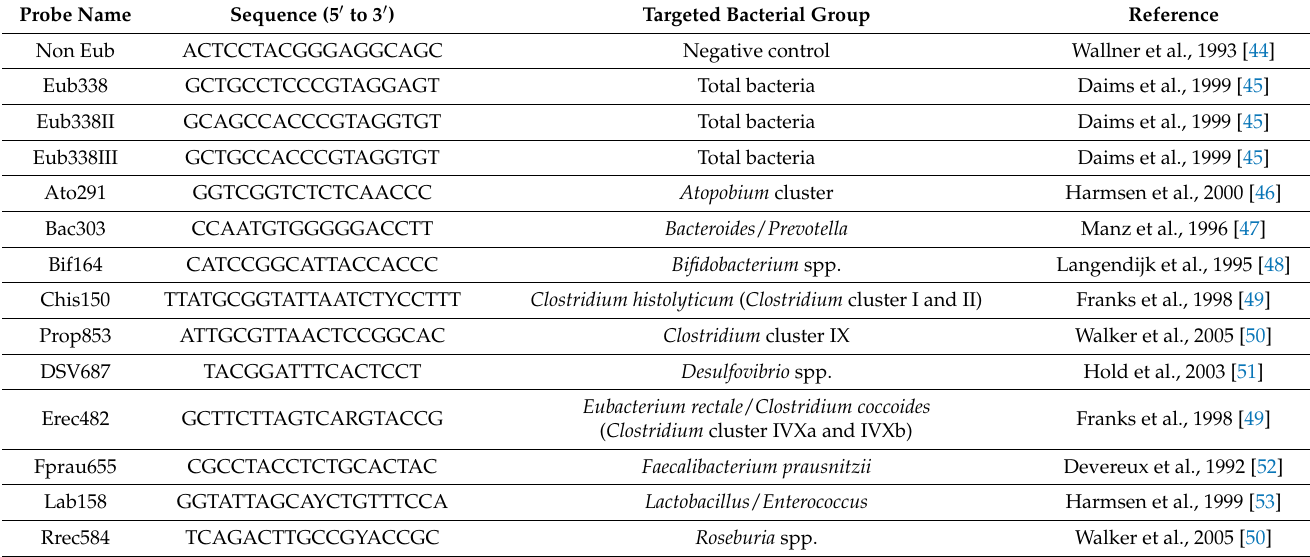
Table 2. 16S rRNA-Targeted Oligonucleotide Probes Used for In Vitro